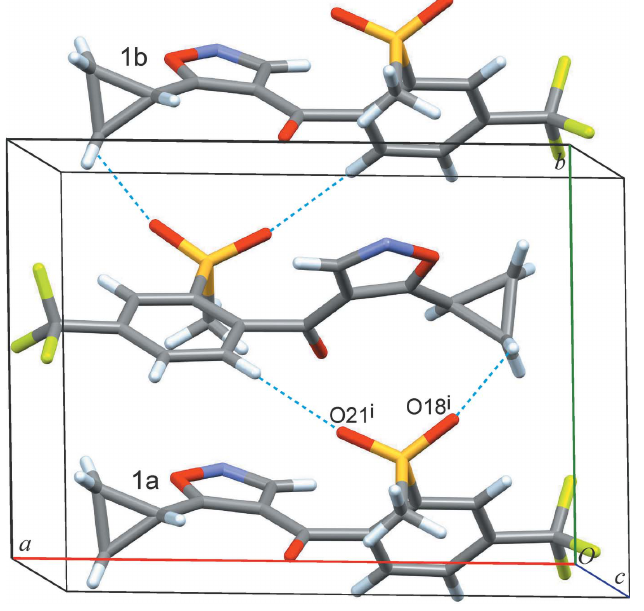
Figure 3 Molecules related by a twofold screw operation form two short C— H (cid:3)(cid:3)(cid:3) O contacts, resulting in a columnar arrangement along the b axis (motif 1a,b).